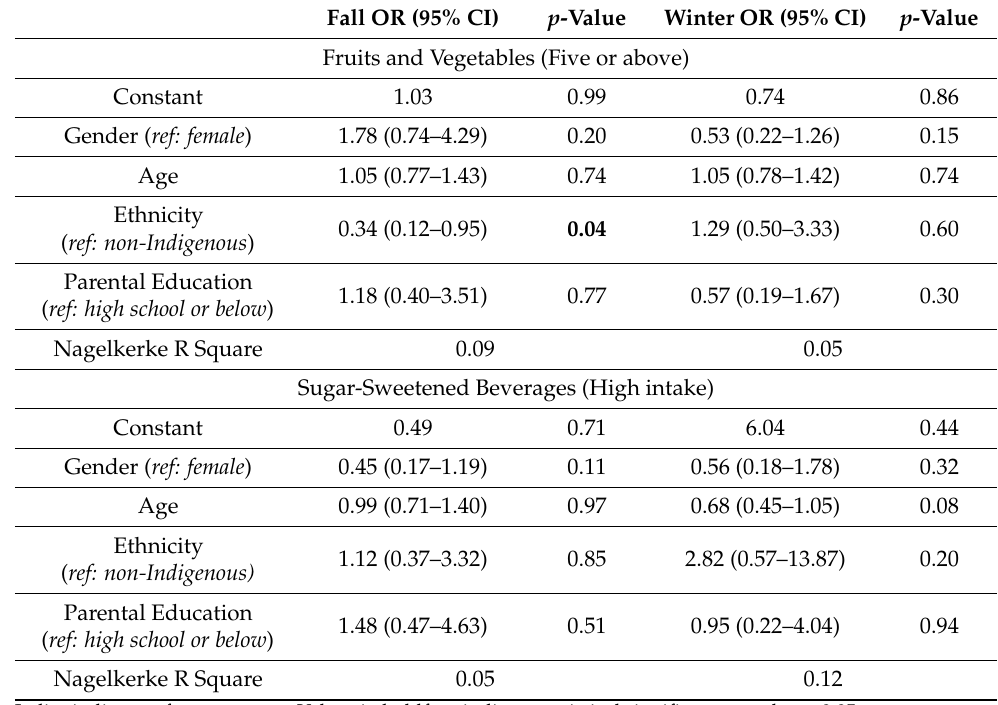
Table 4. Sociodemographic factors associated with FV and SSB consumption, during the fall and